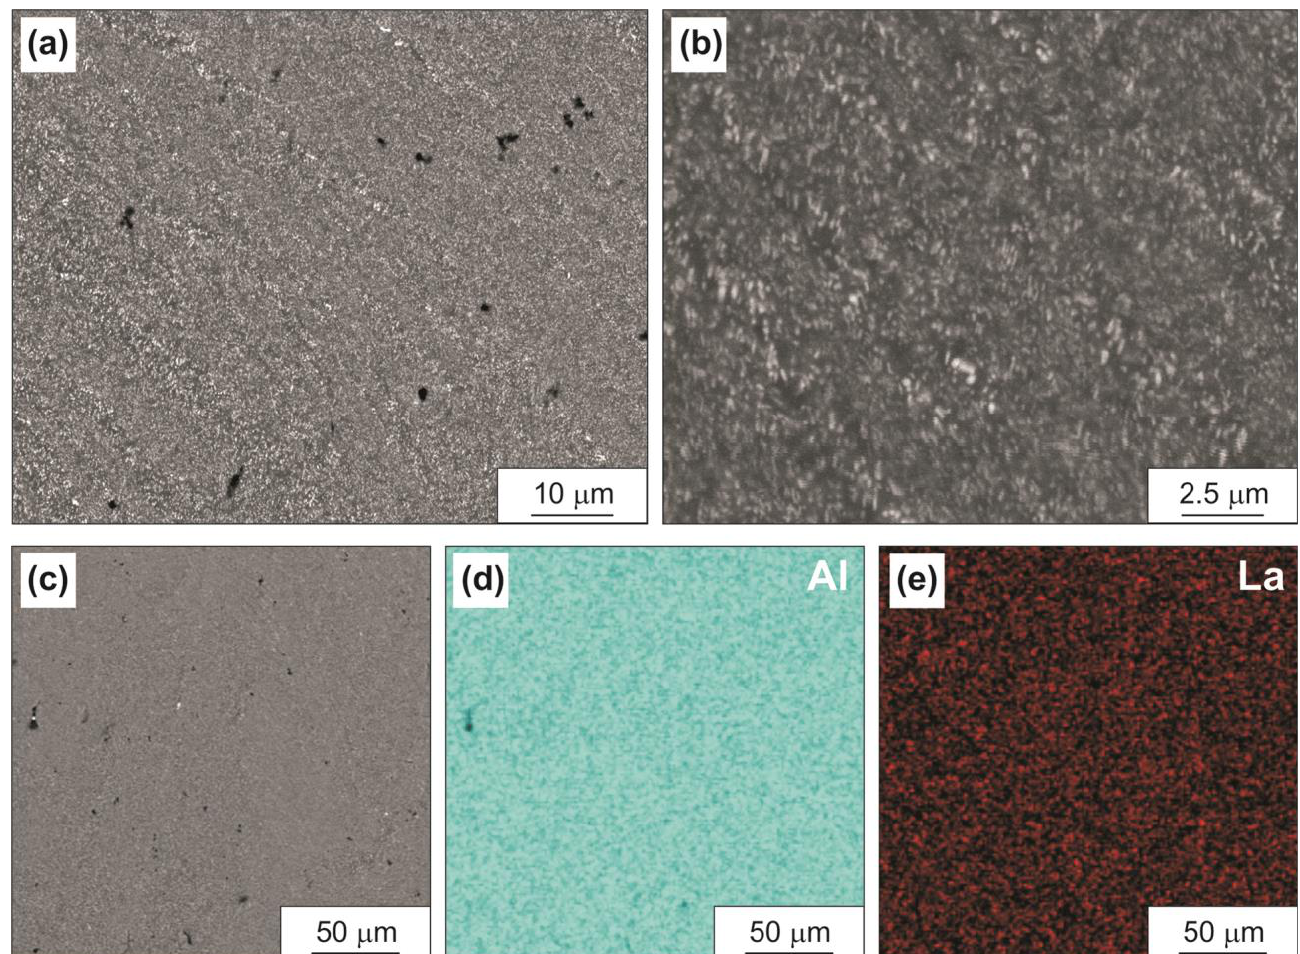
Figure 4. ( a , b ) SEM-cross sectional structure of the aluminum rod of the 2.5-mm diameter composite sample ( e = 4.16) and EDS results ( c – e ): ( c ) — the analyzed area of the structure and chemical distribution maps for ( d ) Al and ( e ) La.